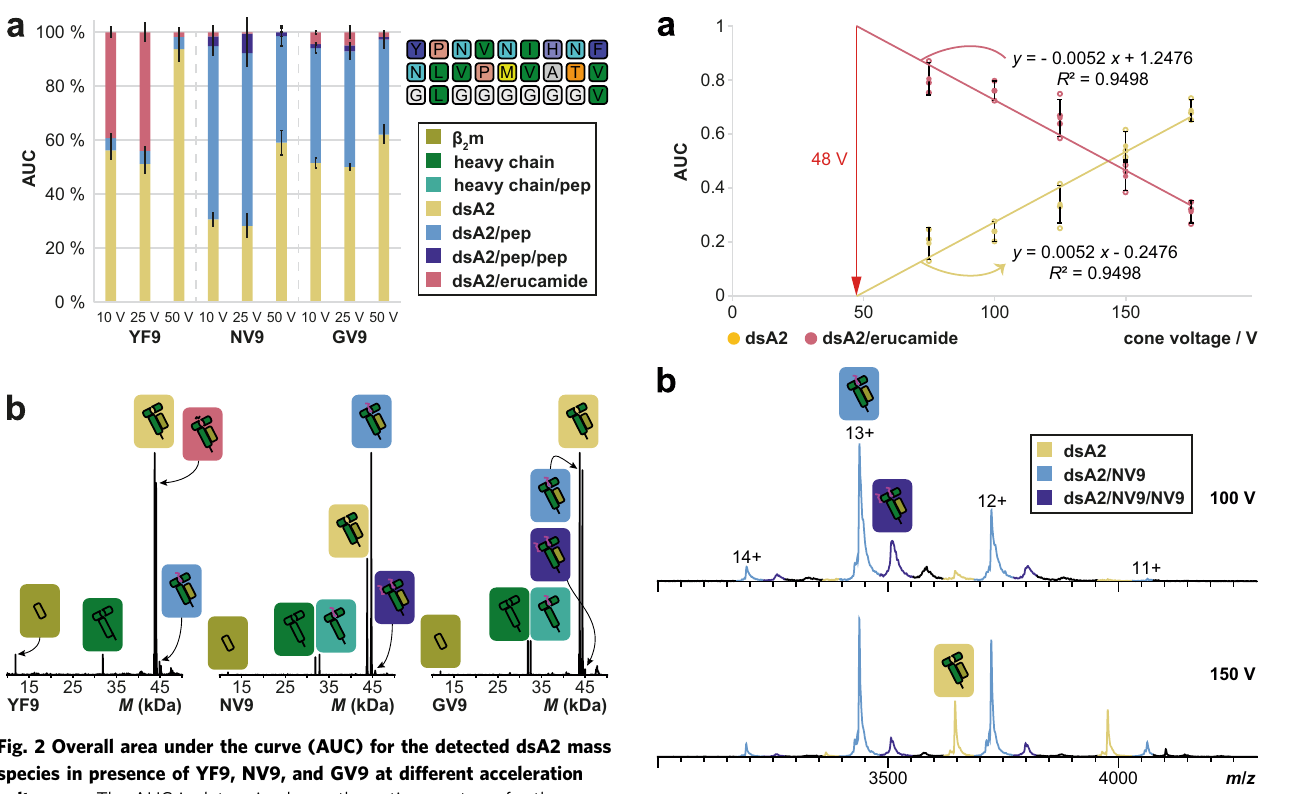
Fig. 3 In-source dissociation causes linear dependence of the ligand- bound dsA2 fraction on cone voltage. a Native MS fractions of dsA2 and dsA2/erucamide are likewise dependent on the activation energy of the cone voltage. As the cone voltage is raised, the percentage of empty dsA2 increases because the adduct binding cannot withstand the energy in the ion source and therefore dissociates. The proportionality is linear, and therefore a theoretical cone voltage of 48 V can be calculated at which a full occupancy with ligand would be reached. This voltage is too low to obtain stable electrospray and a resolved spectrum. b Peptide binding is equally subject to ISD. NV9-bound dsA2 (light blue and dark blue annotated peaks) become less prominent with increasing cone voltage, while empty dsA2 (yellow) increases at the same time.